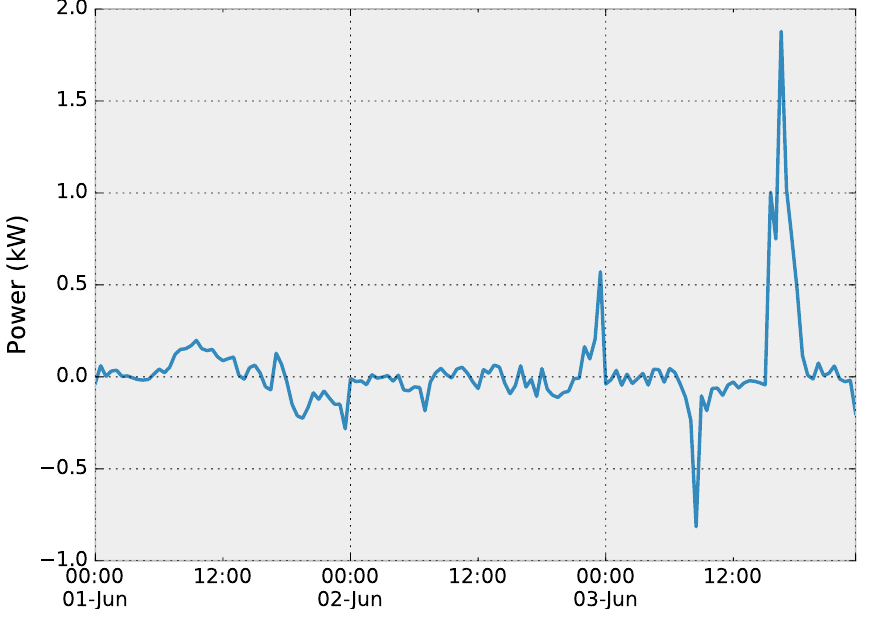
Figure 7. Absolute error on the aggregated GEPP.